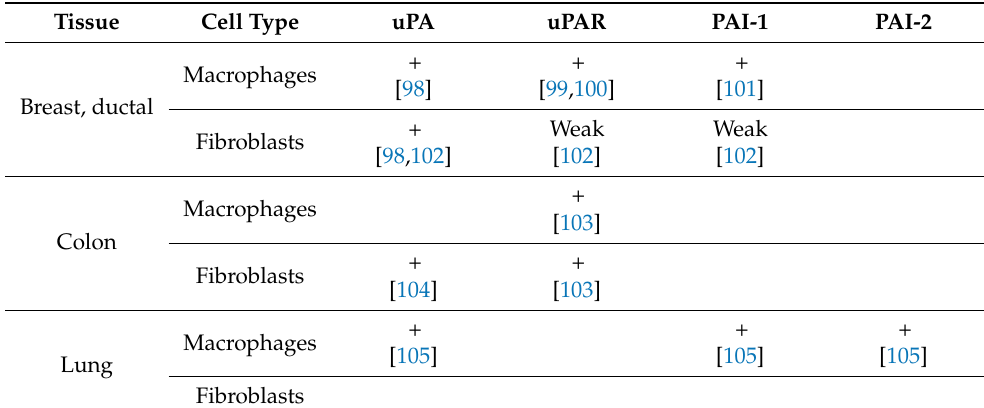
Table 4. Urokinase plasminogen activation system expression in the tumour microenvironment of other solid